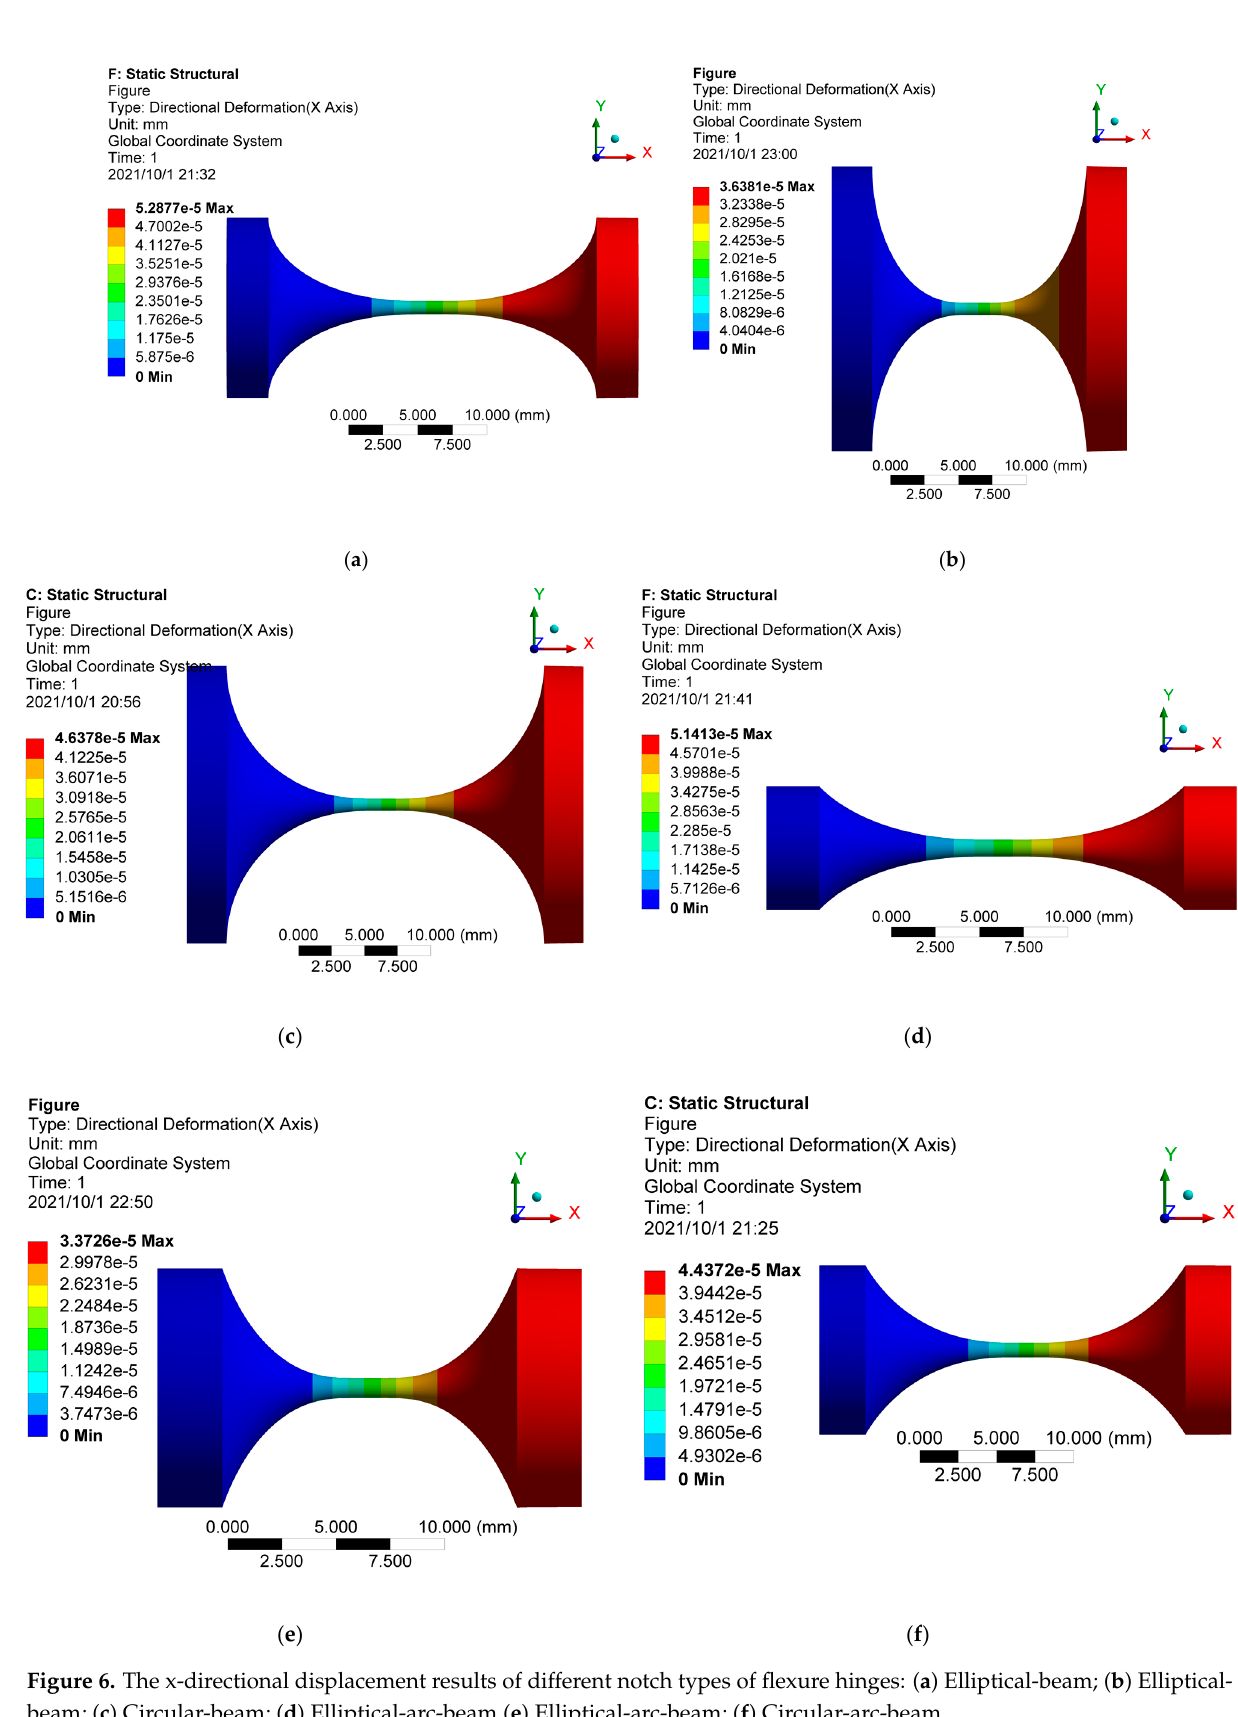
Figure 5. The constraint and load settings in the FEA: ( a ) Fixed support at the left end block and unit force applied onto